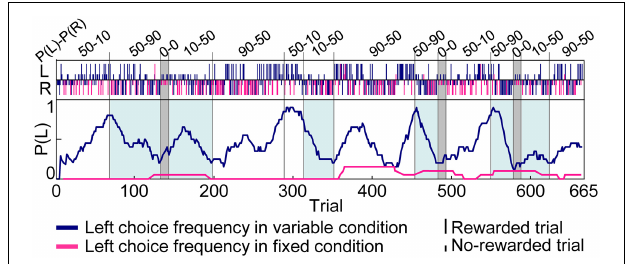
FIGURE 3 | Example of choice behaviors. Vertical bars in the upper portions of the inset indicate the left (L) and right (R) choice in each trial. Tall and short bars show rewarded and non-rewarded trials, respectively. Dark blue and pink bars indicate trials with variable- and fixed-reward conditions and lines in the center indicate the left-choice frequency of a given rat in the last 20 trials. The reward probability of the fixed-reward condition was 50–90% for the left-right choice. The reward-probability setting of variable-reward-condition block is shown at the top. In blocks with a light-blue color, more-rewarding choices of variable- and fixed-reward conditions were identical. Rats succeeded in distinguishing the variable- and fixed-reward conditions for action learning.